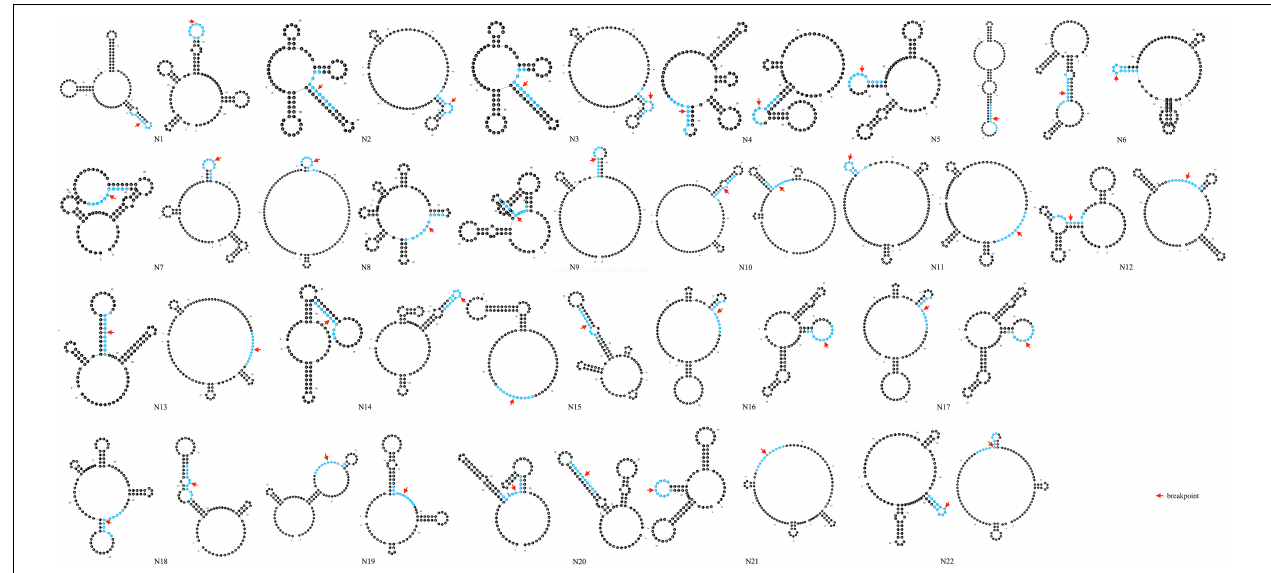
FIGURE 5 | Prediction of secondary structure of 100 bp spanning deletion start and end points of 22 patients. Red arrow indicates the breakpoint. 10 bp around the breakpoint is highlighted in blue